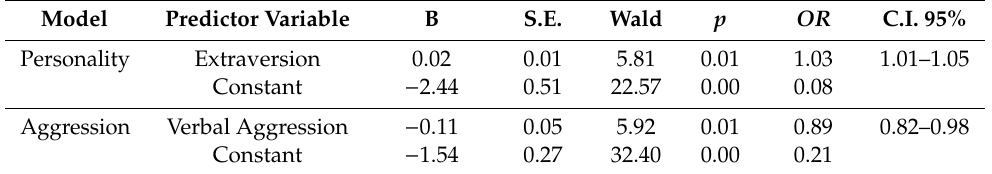
Table 2. Results from the binary logistic regression for the probability of being a cyberbullying victim. Model